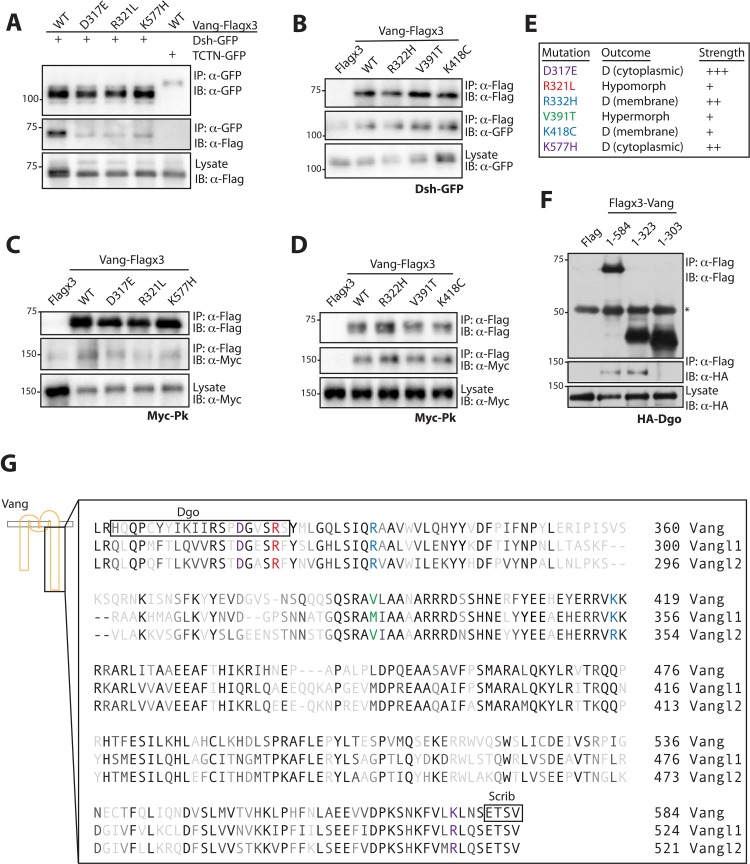
Mutations associated with LOF phenotypes display reduced effector binding.(A) Western blot showing binding between Dsh-GFP and Vang-Flag wild-type or the indicated mutants. Note that Vang-Flag wild-type binds to Dsh-GFP but not the negative control Tctn-GFP. The D317E, R321L and K557H mutants show reduced binding as compared to wild-type Vang. (B) Western blot showing binding between Vang-Flag wild-type or the indicated mutants and Dsh-GFP. The Vang constructs are able to bind to Dsh to the same degree, while no binding is observed with Flag alone. (C) Western blot showing binding between Vang-Flag wild-type or the indicated mutants and Myc-Pk. The D317E, R321L and K577H mutants show a markedly weaker interaction with Myc-Pk as compared to wild-type Vang. (D) Western blot showing binding between Vang-Flag wild-type or the indicated mutants and Myc-Pk. The Vang constructs are able to bind Pk to the same degree. (E) Summary of the phenotypic outcome of investigated mutations, D, (cytoplasmic) and (membrane) distinguish between the two types of dominant mutations observed, which is based on their cellular localization. Colors are assigned based on different outcomes, also shown is the relative phenotypic strength of each mutation (see Figures 3 and 4). (F) Western blot showing the regions of Vang required for interaction with Dgo. Note that full-length Vang (1-584) and a construct containing residues 1–323 of Vang are able to interact with HA-Dgo. While a construct containing residues 1–303 does not interact, suggesting residues 304–323 in Vang are essential for its interaction with Dgo. (G) Schematic showing the C-terminal sequence of Vang, and human Vangl1 and Vangl2. Mutated residues are highlighted in colors associated with their phenotypic outcome as in E. Also highlighted are regions of Vang essential for its interaction with Dgo and Scribble, note their proximity to specific residues.